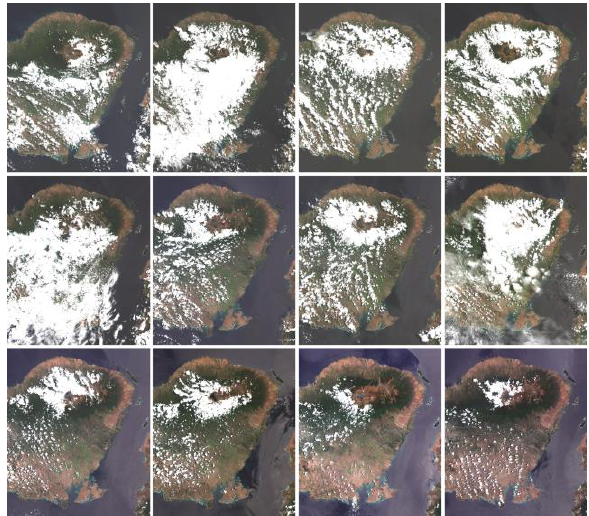
Figure 3. Sentinel-2 MSI dataset for POST-disaster observation. From top left, to bottom right image: August 06, 11, 21, and 26; September 05, 10, 15, 20, 25, and 30; and October 10 and 30